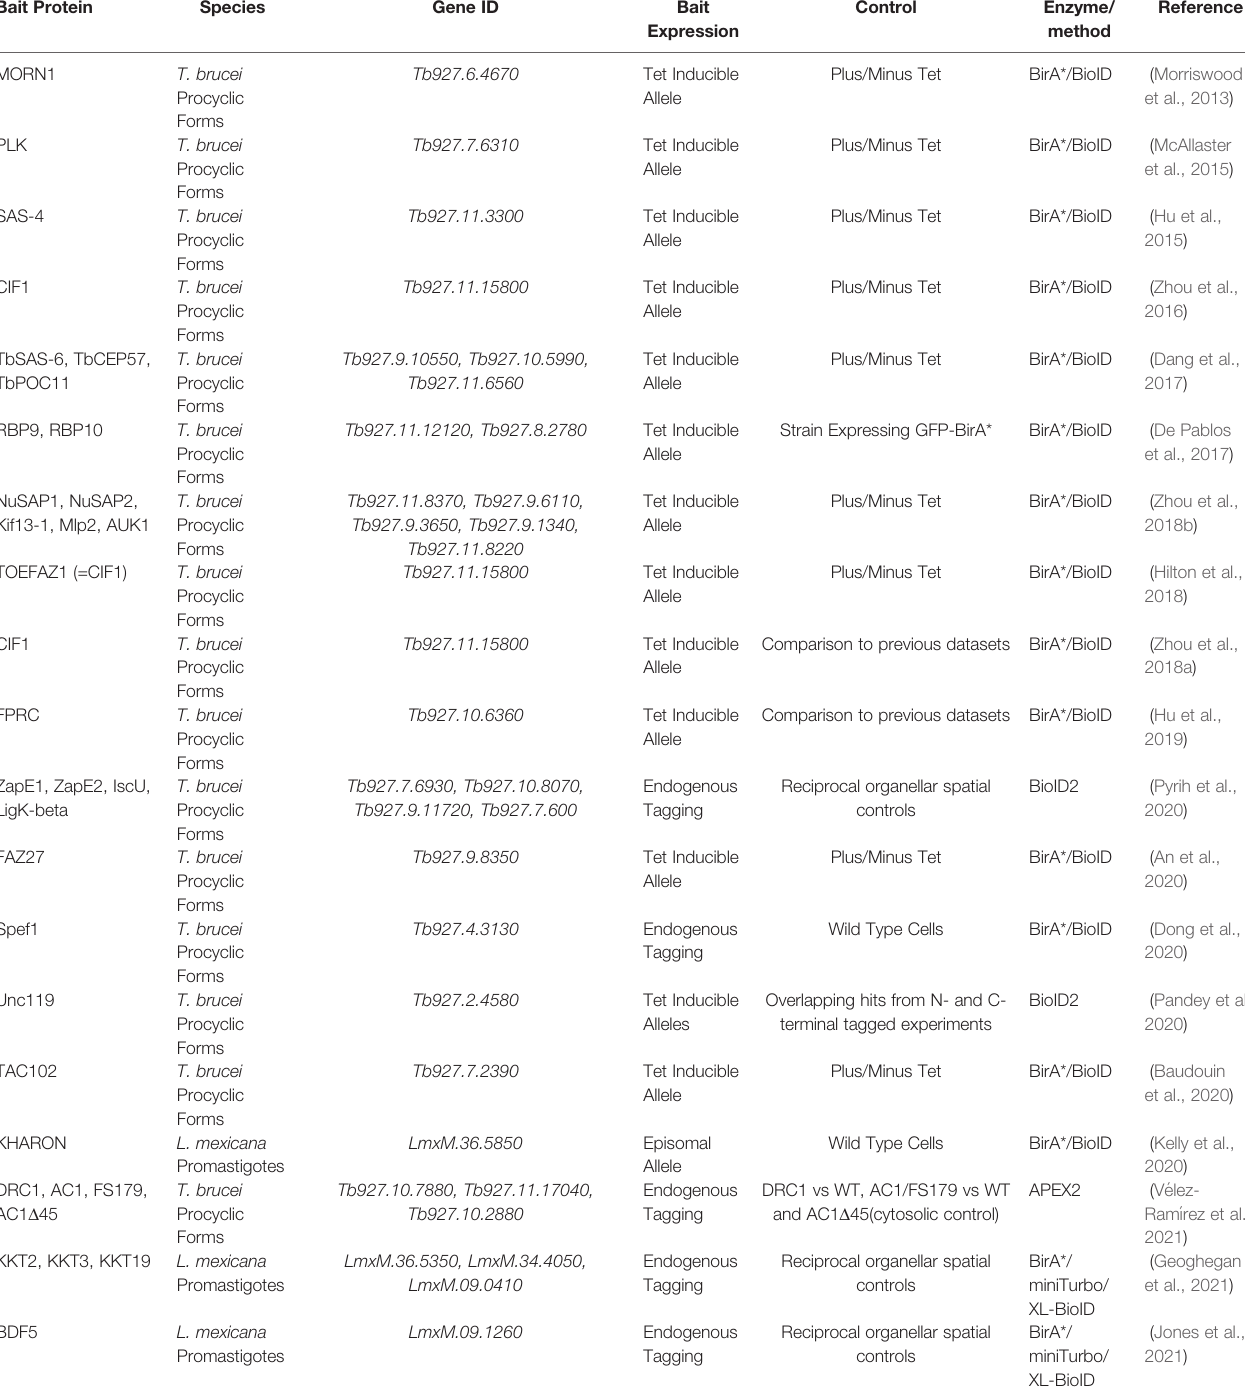
TABLE 1 | List of proximity biotinylation studies conducted in